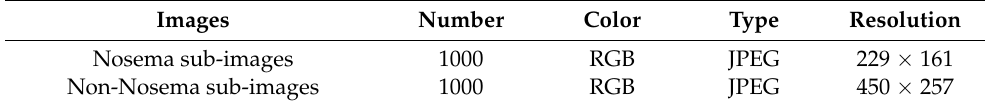
Table 1. Dataset of extracted sub-images.